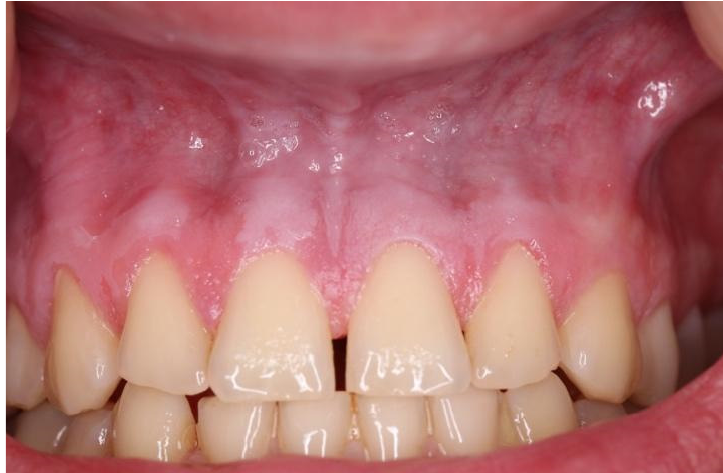
Figure 1. White, leathery lesion above tooth nr. 13 to tooth nr. 22.